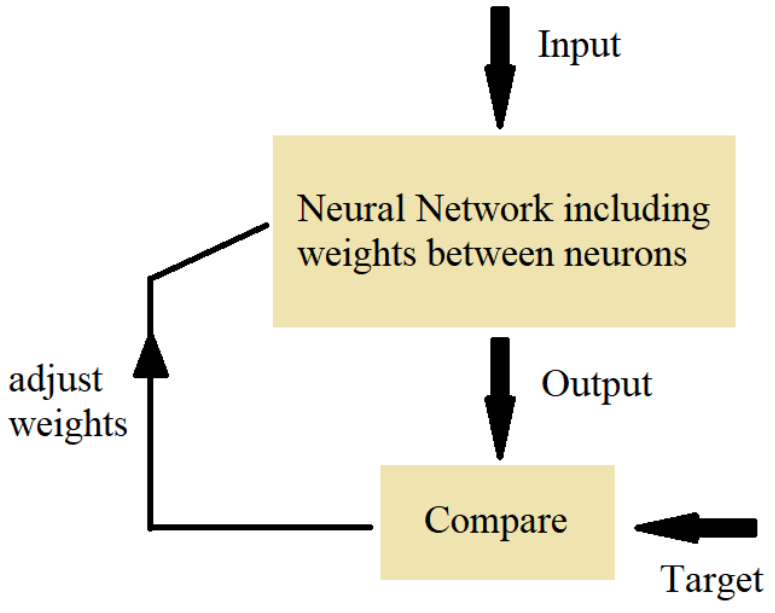
Figure 5. Schematic diagram of ANNs (adopted from [19]). The network used in this study has four inputs, including the middle evaporating and condensing temperatures and the superheating and subcooling temperatures. In the hidden layer, the number of neurons was controlled and adjusted to avoid